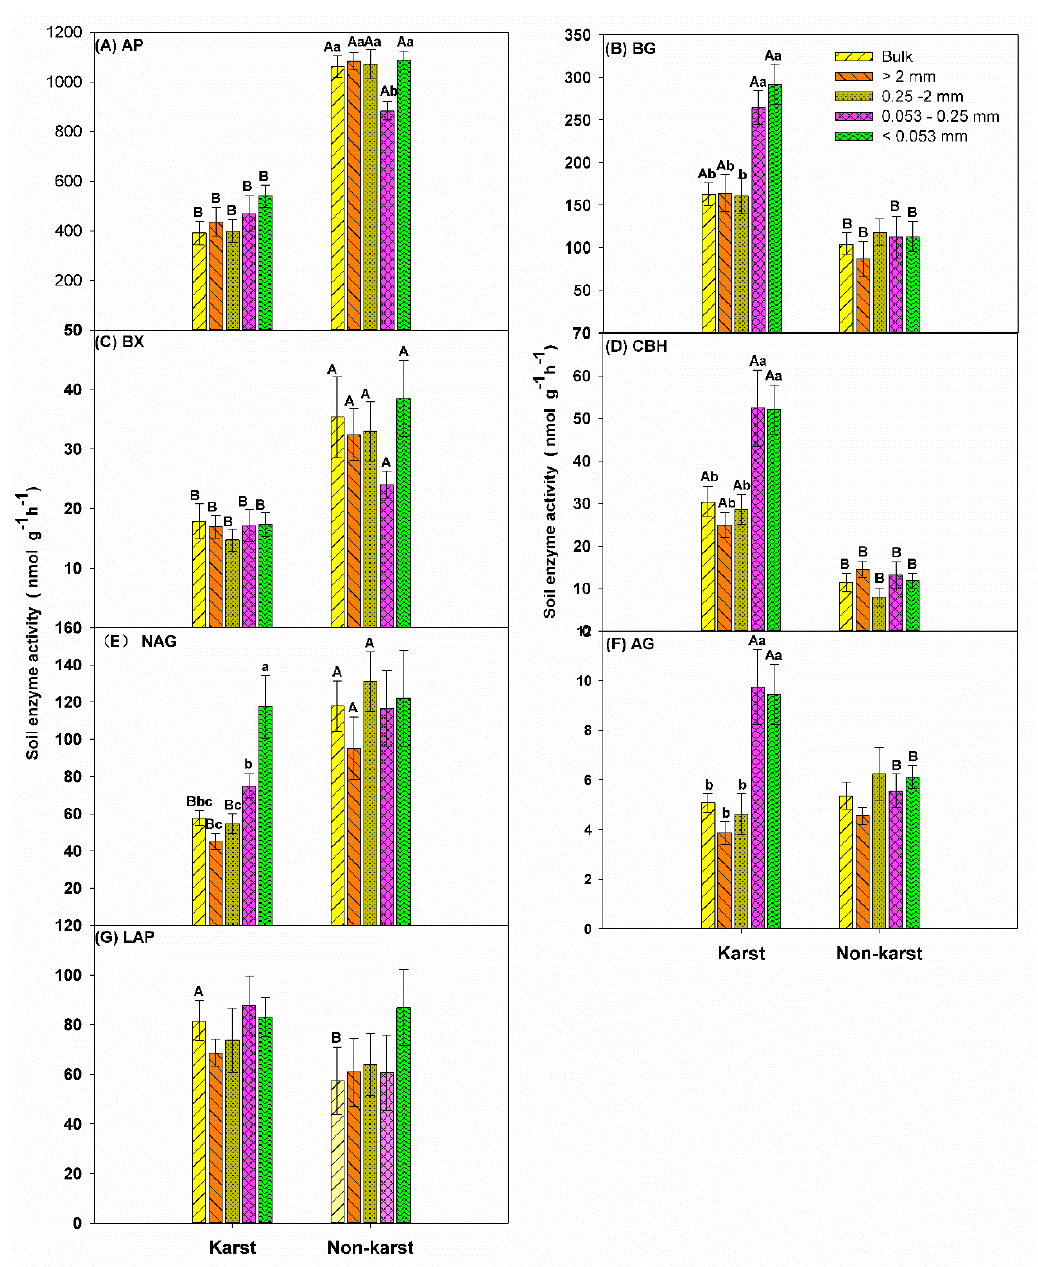
Figure 1. Soil enzyme activity (nmol h − 1 g − 1 ) in the bulk soil and aggregates in the forest ecosystems. Error bars represent the standard deviation. Capital letters indicate differences among the forest ecosystems in the same aggregate size. Lowercase letters indicate differences in the aggregate size fractions in the same forest ecosystem. Phosphatase (AP), β -glucosidase (BG), β -1, 4-Xylosidase (BX), cellobiohyrolase (CBH), β -N-acetylglucosaminidase (NAG), α -Glucosidase (AG), leucine aminopeptidase